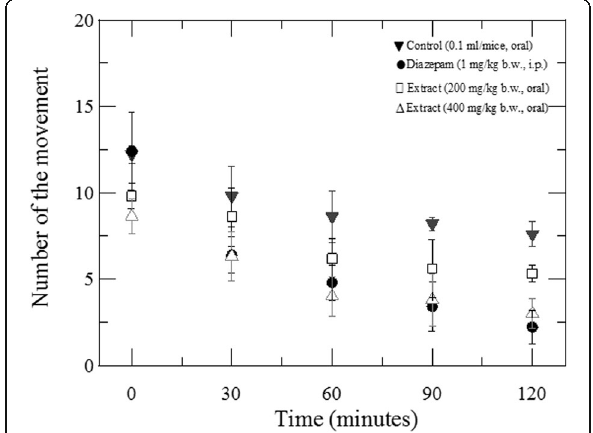
Fig. 2 Effect of the ethyl acetate extract of D. malabarica seeds in hole cross test of mice